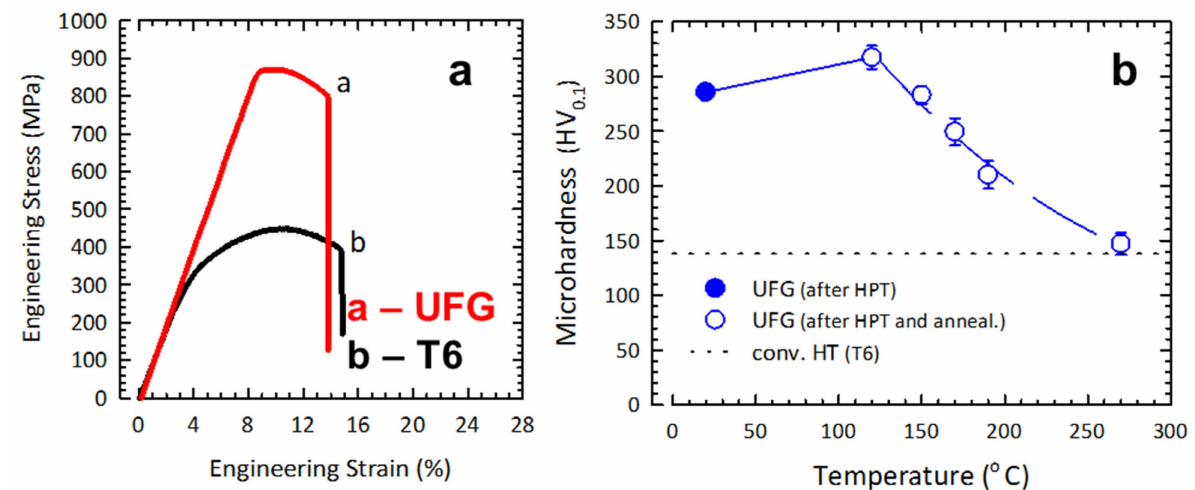
Figure 2. Engineering stress–strain curves for the 2024 alloy in the UFG and coarse-grained states ( a ); dependence of microhardness on temperature ( b